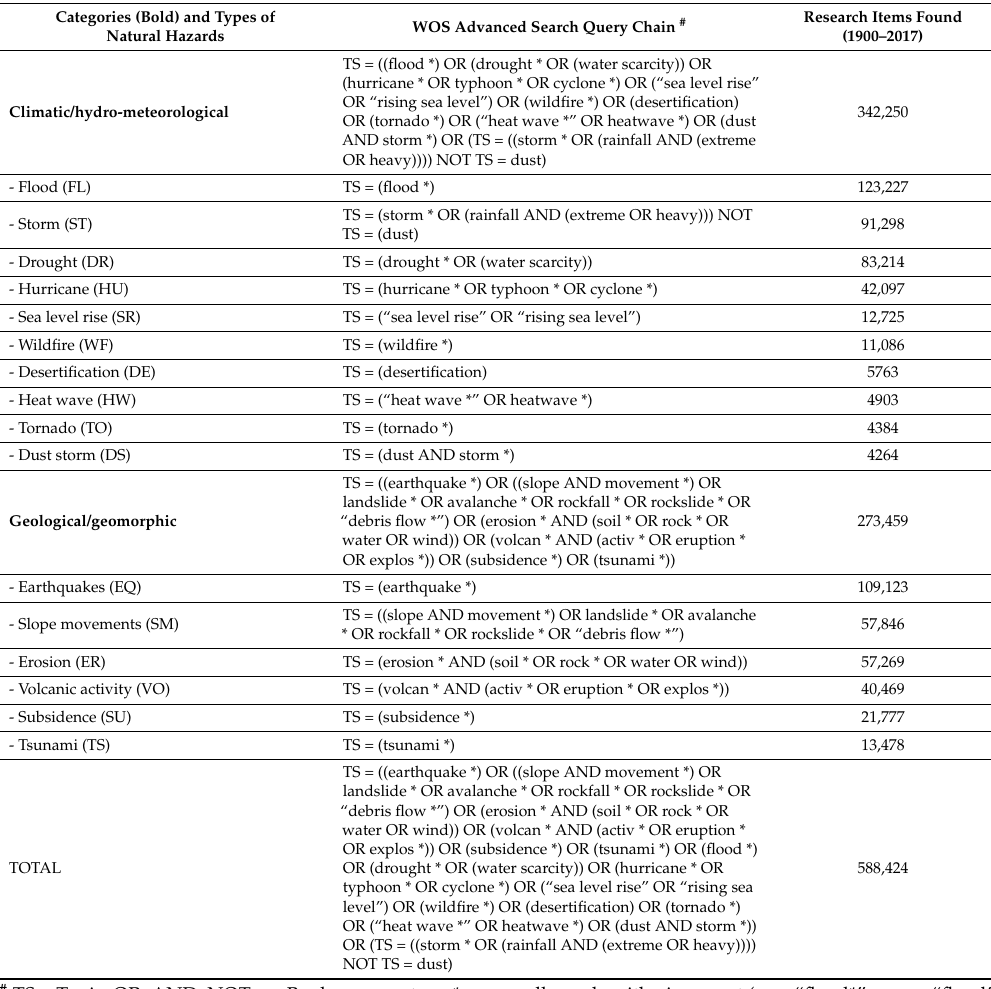
Table 1. Classification of natural hazards used in this study (adapted from [15,16]), WOS search query chains, and the number of research items found (June 2018). Note that numbers of research items found for individual categories (climatic/hydro-meteorological; geological/geomorphic), as well as for the total, do not correspond with the sum of research items found for individual types of natural hazards, because some items are focusing on two or more types of natural hazards simultaneously (multi-hazard items, see Section